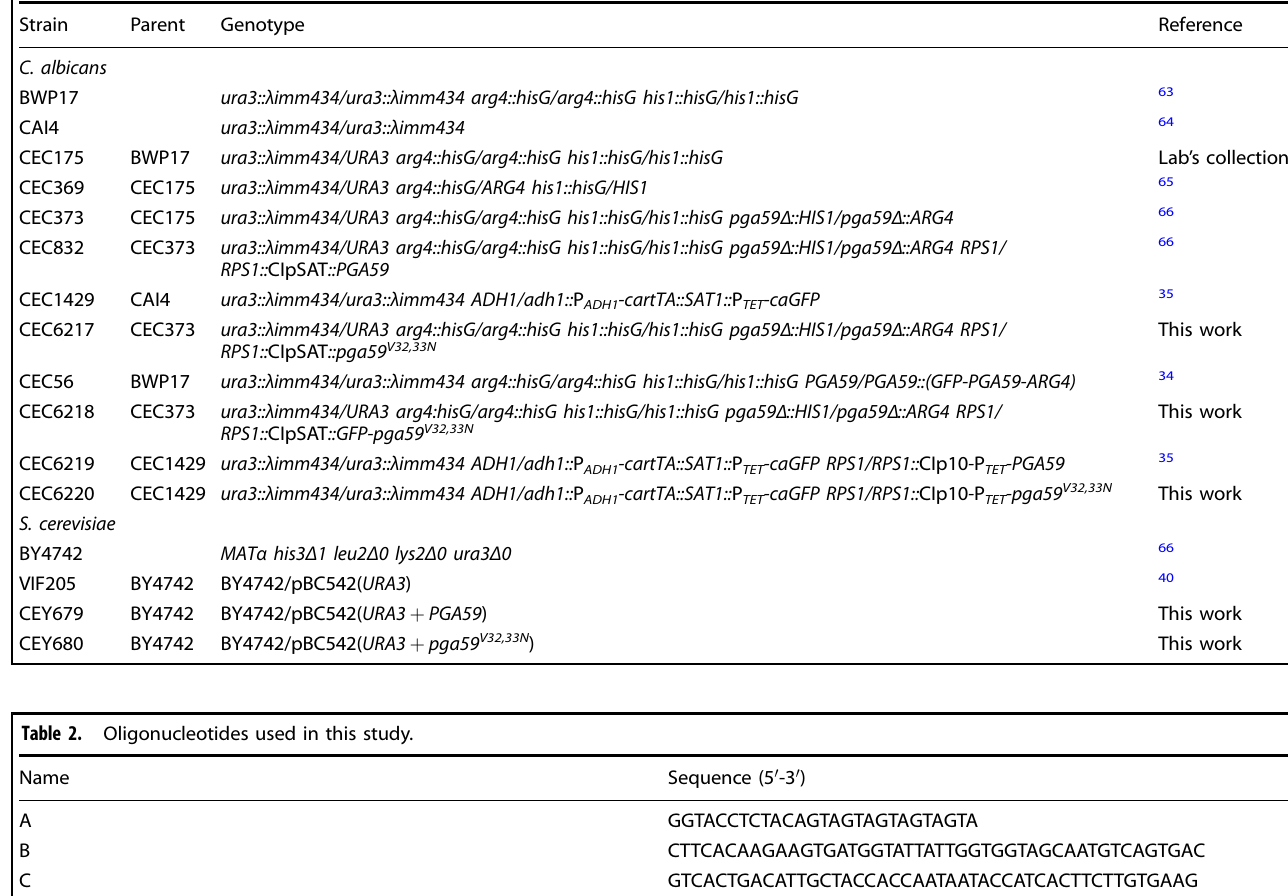
Table 1. Strains used in this study.